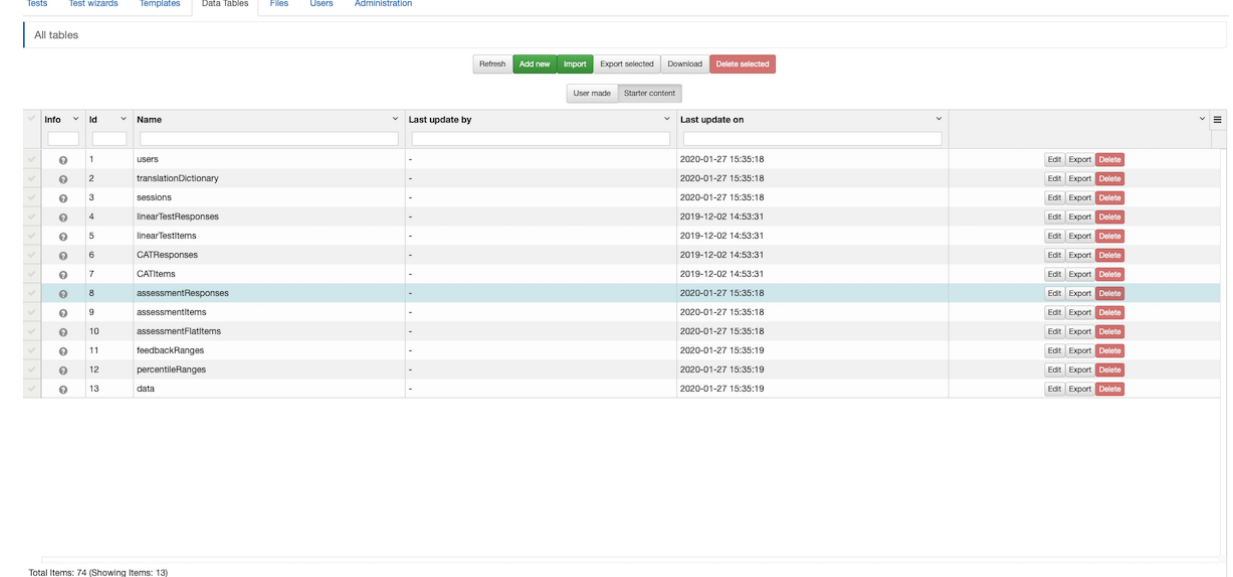
Figure 1. Concerto screenshot: creating a data table to store item responses.